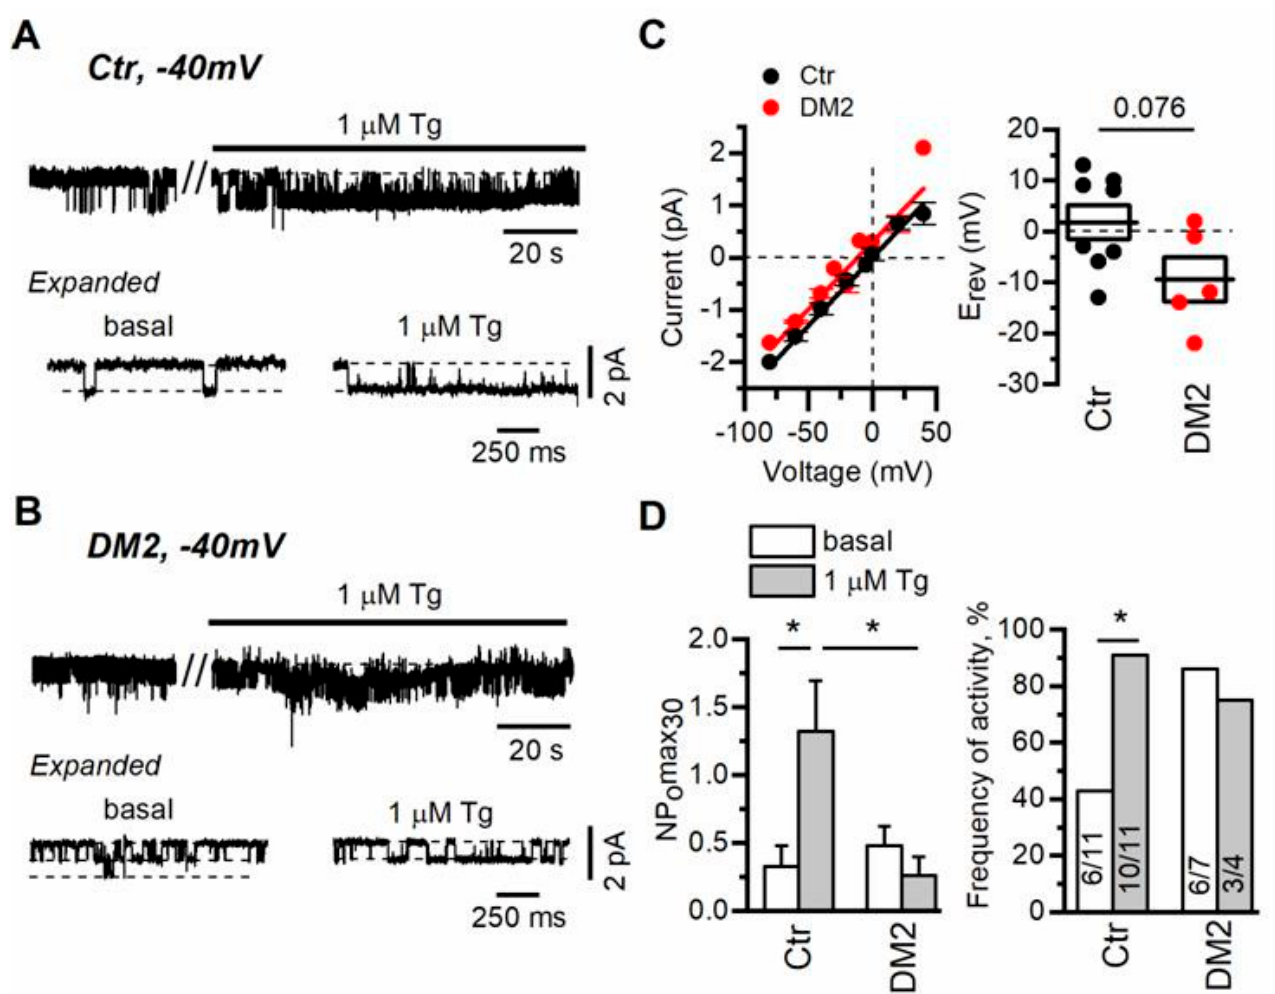
Figure 4. Diabetes development cancels the regulation of TRPC6 channels by Ca 2+ store depletion in rat podocytes. ( A , B ) Representative traces of TRPC6 currents recorded in cell-attached configuration in freshly isolated rat glomerular podocytes from control ( A ) and diabetic ( B ) groups. The membrane potential was held at − 40 mV. Shown are basal currents and currents after bath application of 1 µ M thapsigargin (Tg). Fragments of the recordings are shown at the bottom on an expanded time scale. ( C ) The current–voltage relationship and reversal potential of observed TRPC6 channels. Data were analyzed by two-tailed Student t -test. ( D ) Left—the open channel probability collected during 30 s of maximal activity (NPomax30) before and after bath application of 1 µ M Tg. Data are presented as mean bar plots and paired data points. Line indicates the median value. Data were statistically analyzed by Kruskal–Wallis test followed by Dunnett’s test. ( D ) Right—the frequency of TRPC6 channel activity observation as percentage of all patches with TRPC6 activity in the group. In the bars are shown the number of active recordings at these conditions over total number of recordings with activity. Data were statistically analyzed by Barnard’s exact test. * indicate p values of